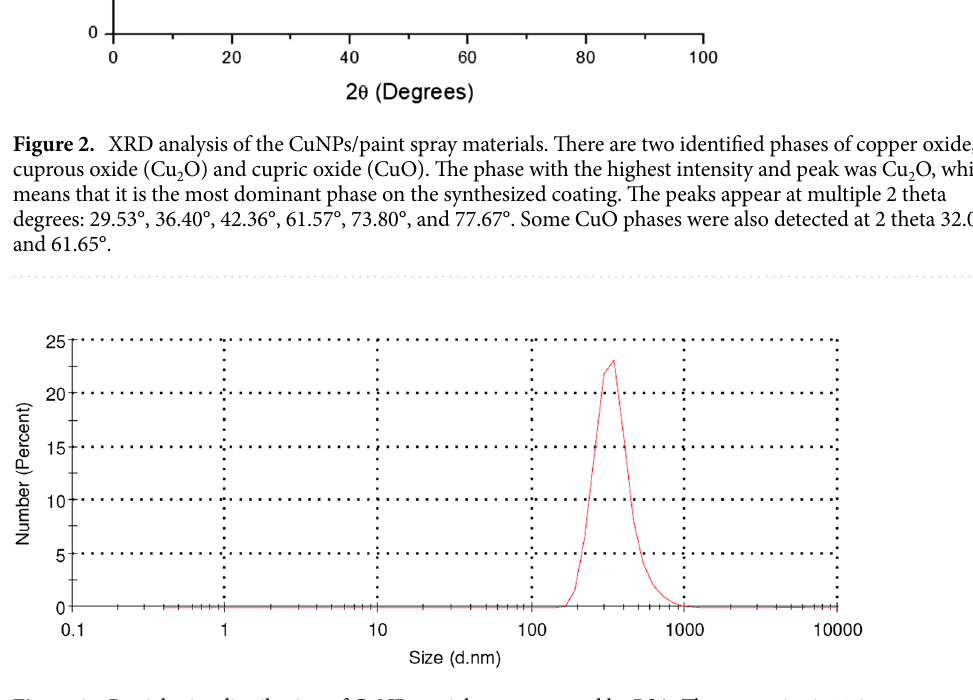
Figure 3. Particle size distribution of CuNP particles as measured by PSA. The mean size is 576